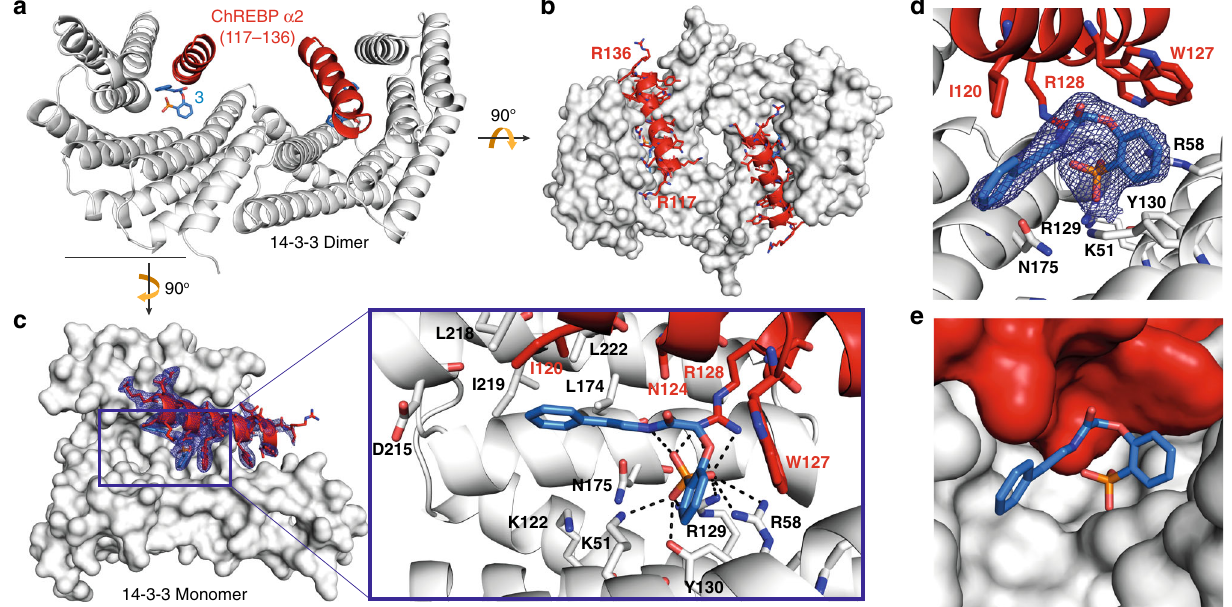
Fig. 3 Co-crystal structure of 14-3-3 β in complex with the ChREBP α 2 peptide and stabilizer 3. a Side view of the 14-3-3 dimer (white cartoon representation) bound by two ChREBP peptides (red cartoon) and two 3 molecules (blue sticks). b Top view displaying the antiparallel orientation of the ChREBP α helices in the 14-3-3 dimer. c Front view of one 14-3-3 monomer (white surface) bound by one ChREBP α -helix and 3 . Final 2F o – F c electron density (blue mesh, contoured at 1.0 σ ) displayed for the ChREBP peptide and 3 . The panel highlights the interactions 3 makes with 14-3-3 and ChREBP residues (relevant side chains are displayed in stick representation). Polar contacts are displayed as black dashed lines. d , e Detailed view of the composite pocket occupied by 3 created by ChREBP and 14-3-3 together, illustrating its interface-binding character. Both phenyl rings of 3 make hydrophobic contacts with side chains of both proteins, as observed for the phenylphosphonate with W127 of ChREBP, and the second phenyl with I120 of ChREBP and I219, L222, and L174 of 14-3-3. Residues of both protein partners that make up the binding pocket are represented as cartoon and sticks ( d ) or surface ( e ). Table 1 Data collection and re fi nement statistics (molecular replacement).